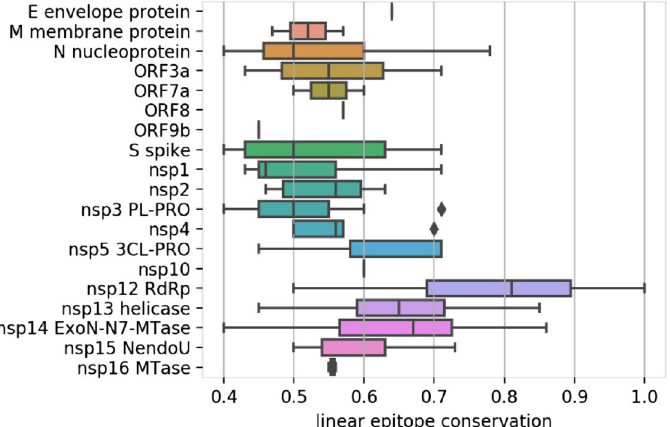
Figure 2. Distribution of conservation levels (1 = 100% identity) of SARS-CoV-2 linear epitopes compared to our comprehensive database of protein sequences from HCoV endemic strains. Epitopes located on essential enzymes such as the RdRp and helicase are the most conserved.